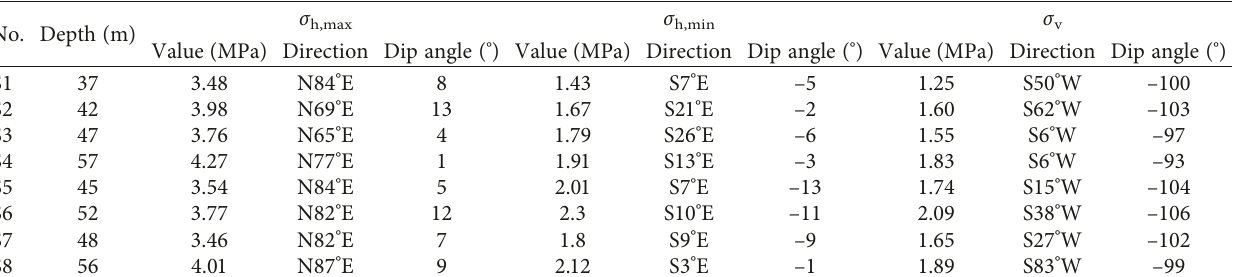
Table 5: Survey results of in situ